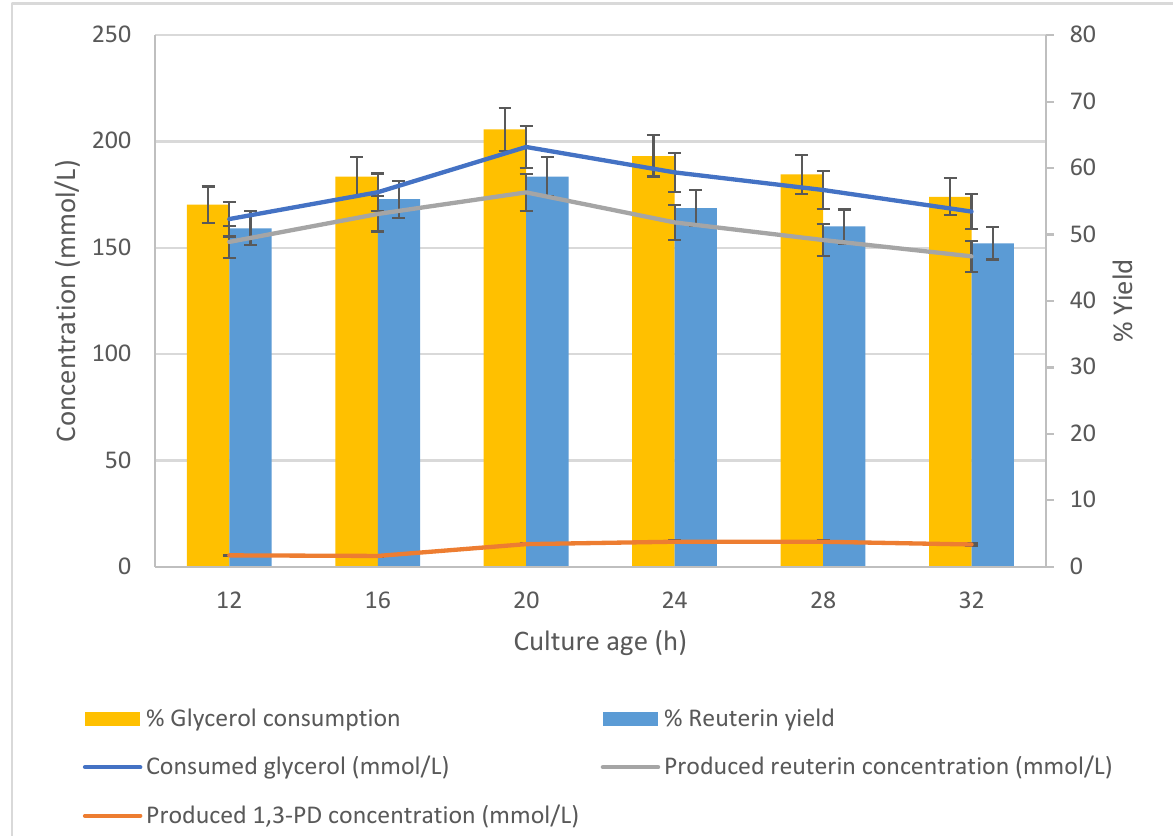
Figure 9. Effect of culture age on reuterin production.